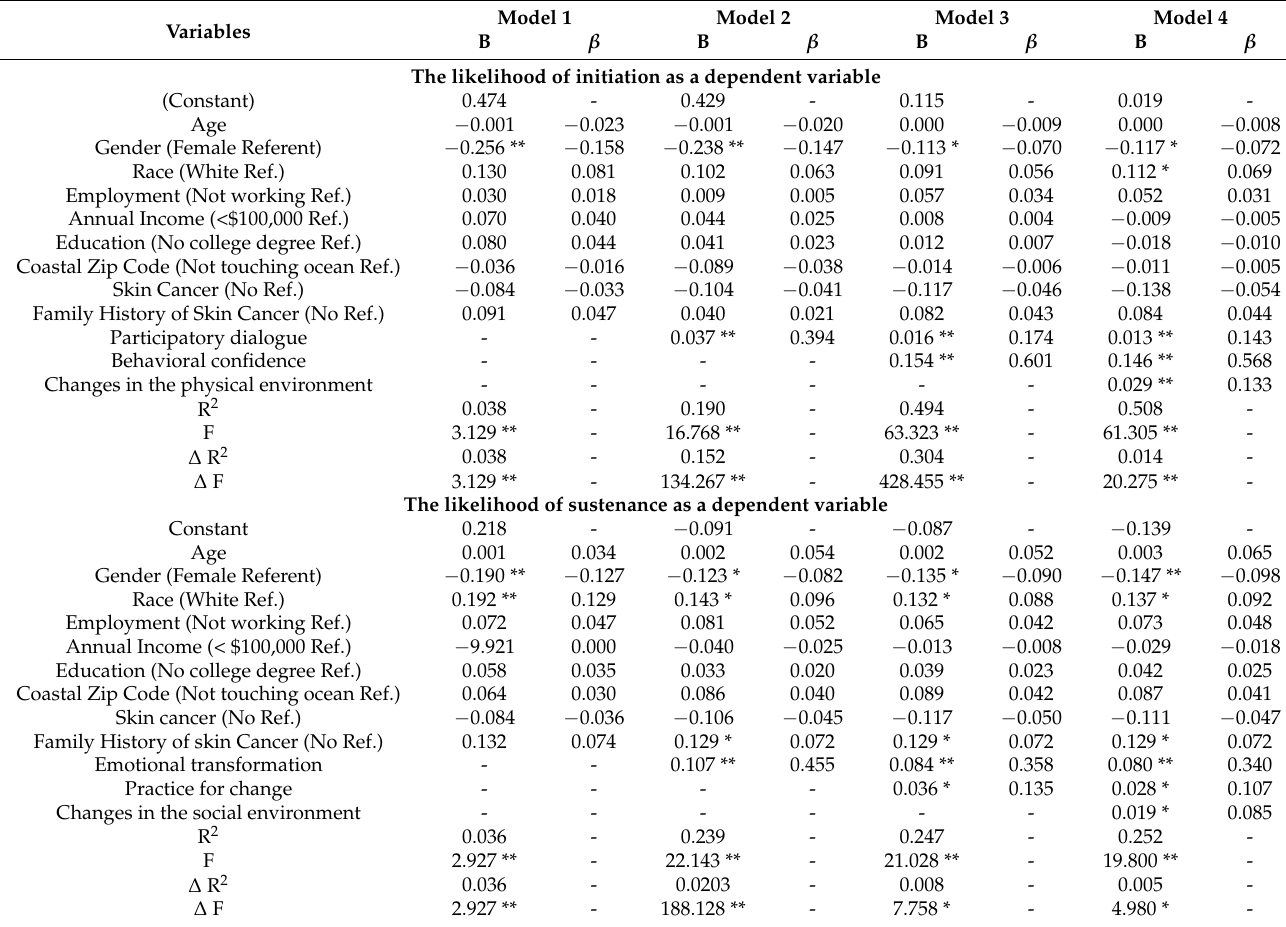
Table 4. Hierarchical Multiple Regression (HRM) predicting likelihood of initiation and sustenance among respondents who did not use sunscreen ( n =